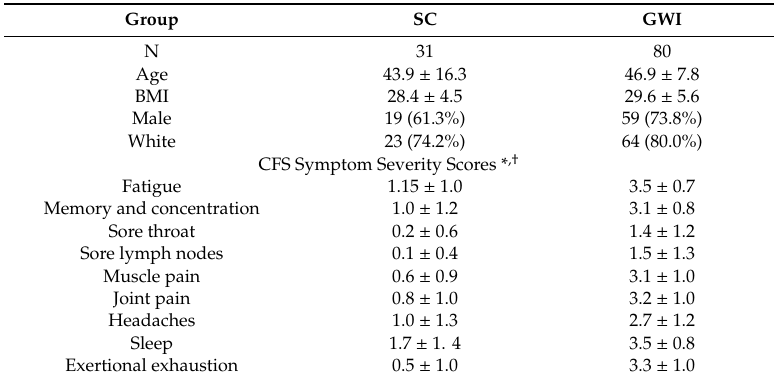
Table 1. Demographics (mean ±